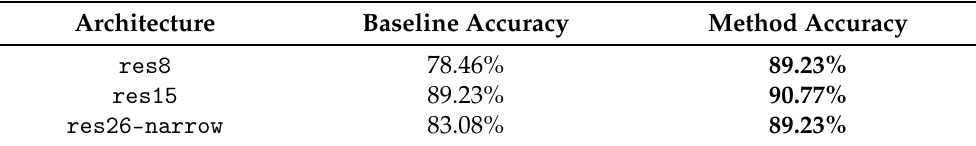
Table 5. The test accuracy after the fine-tuning on the target data set. The best result for each architecture is